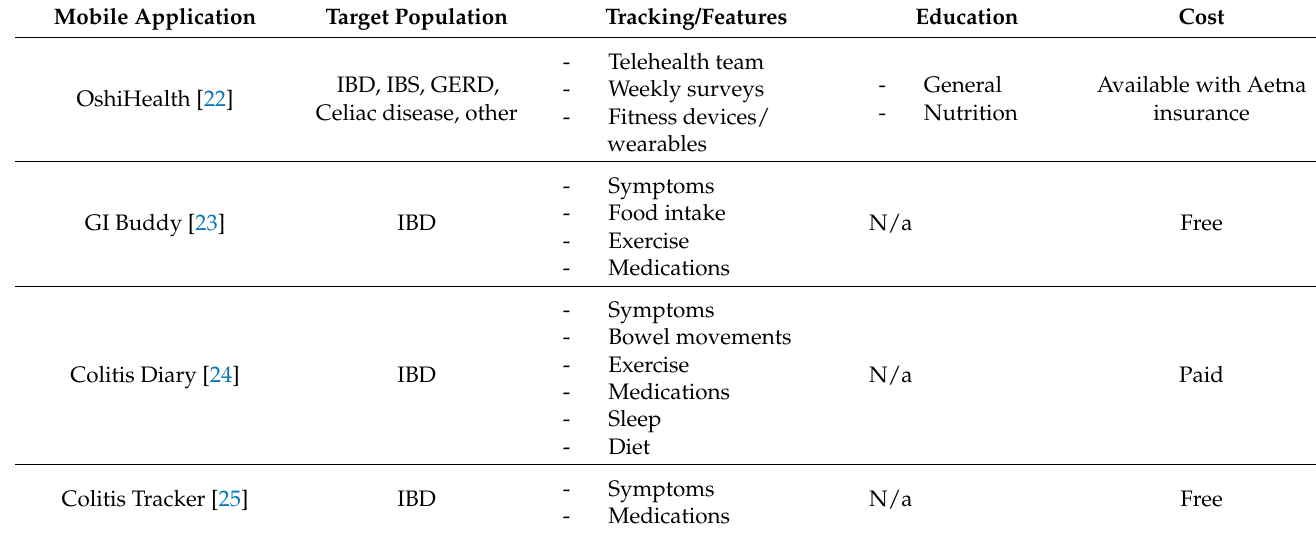
Table 3. Personal Mobile Applications for IBD